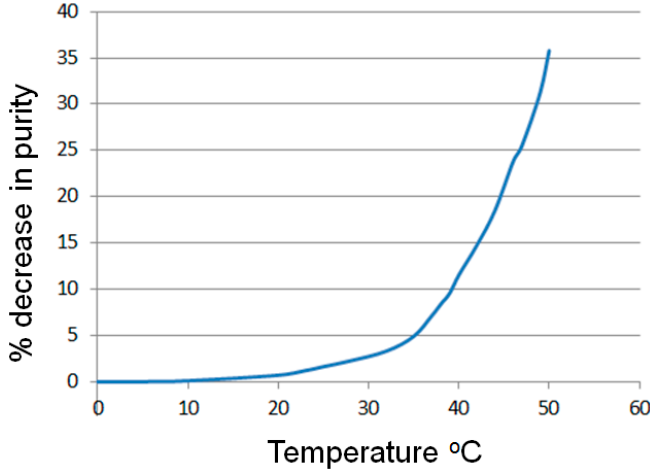
Figure 2. Plot of the percentage decrease in phenyl diazonium output against a change in temperature for phenyl diazonium.